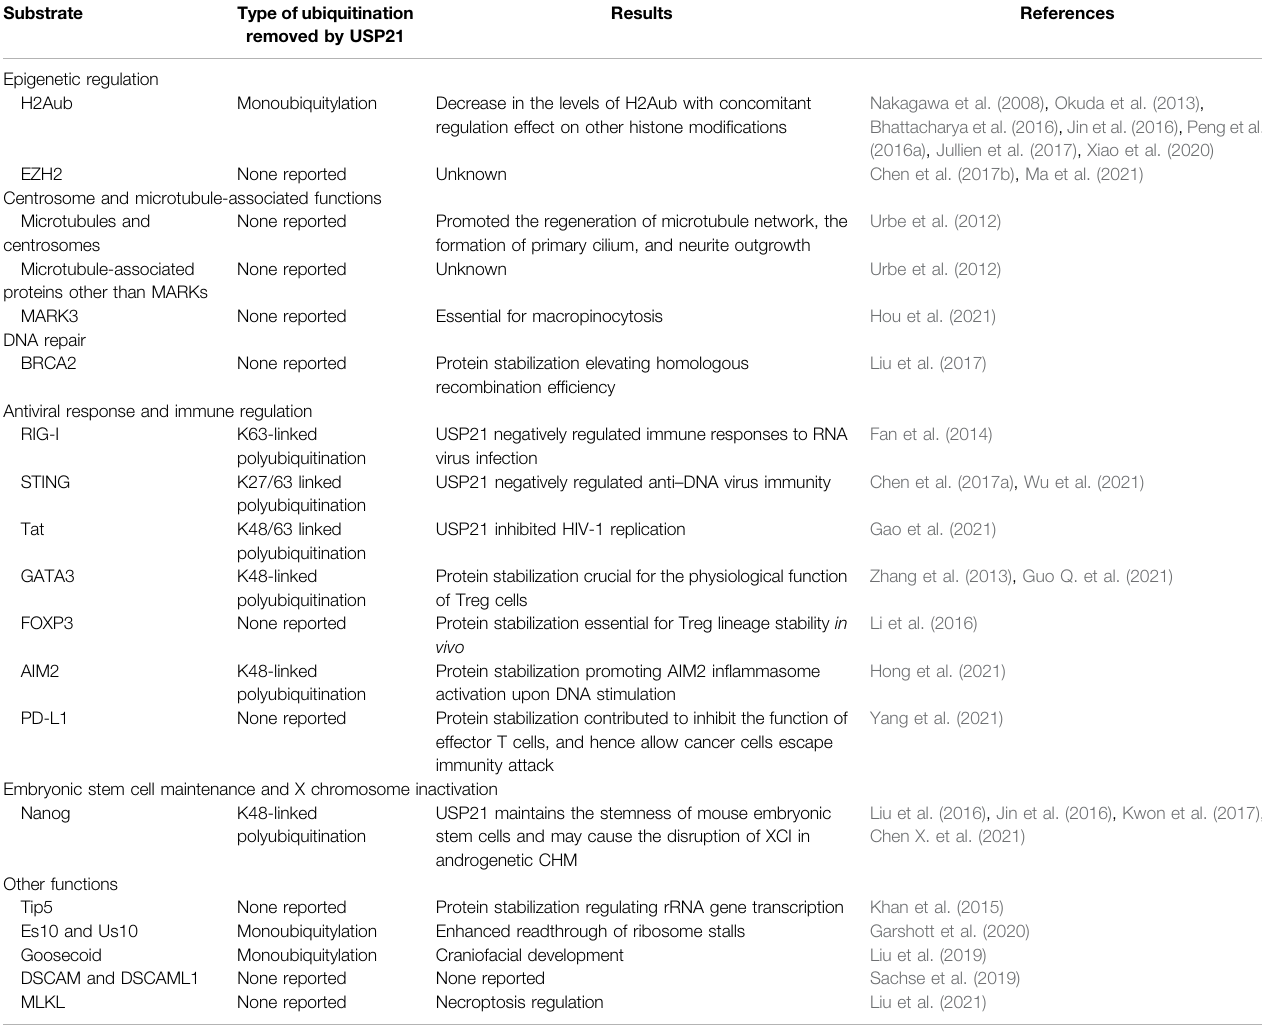
TABLE 2 | Substrates of USP21 in biological